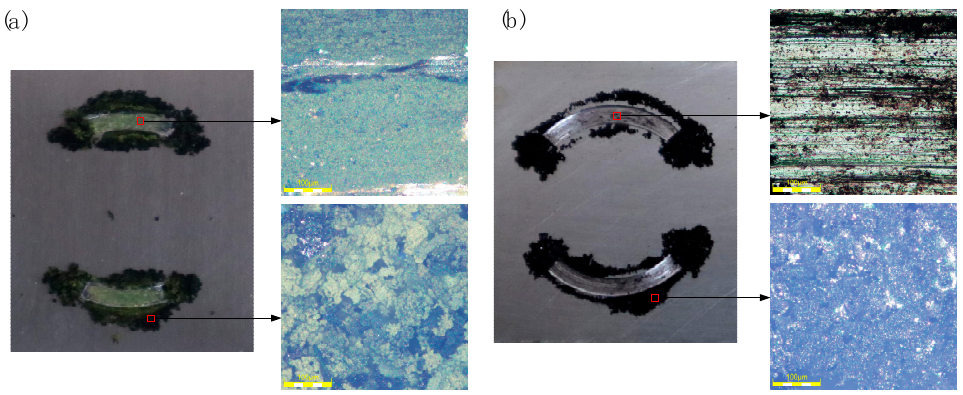
Figure 3. Optical observation of the worn area and debris: ( a ) fretting; ( b ) sliding.